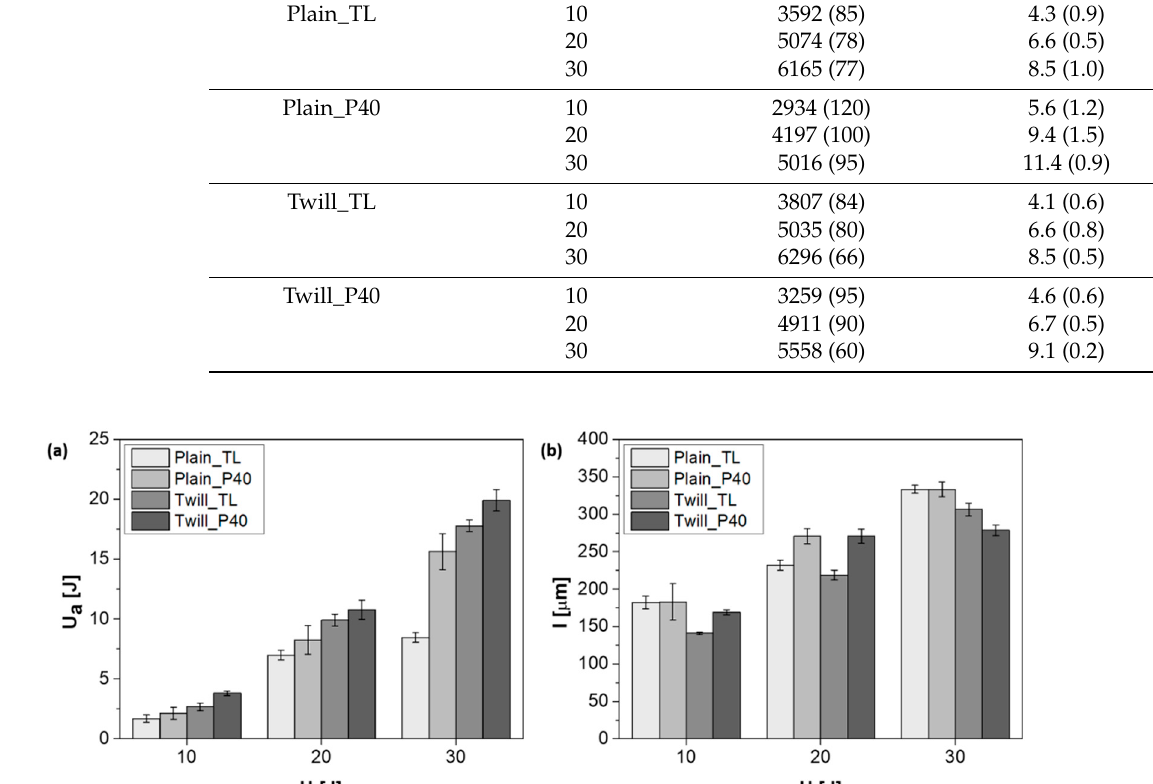
Table 3. Impact parameters at indentation for all the samples. Standard deviations are reported in brackets.